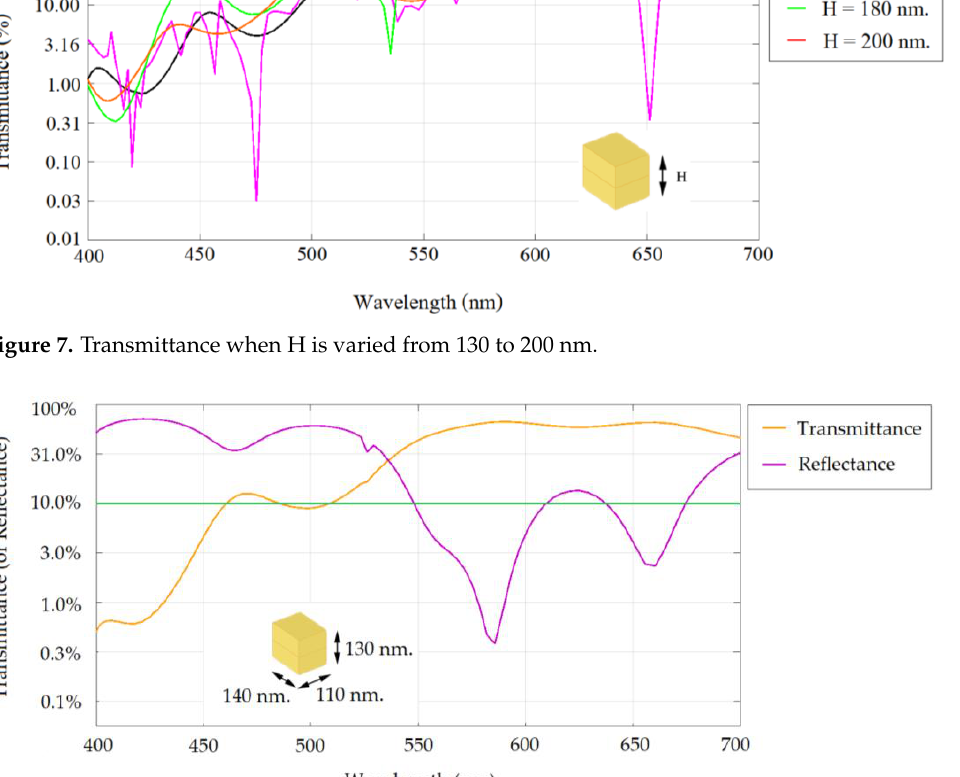
Figure 8. Transmittance and reflectance of the nanocube at optimal dimension.